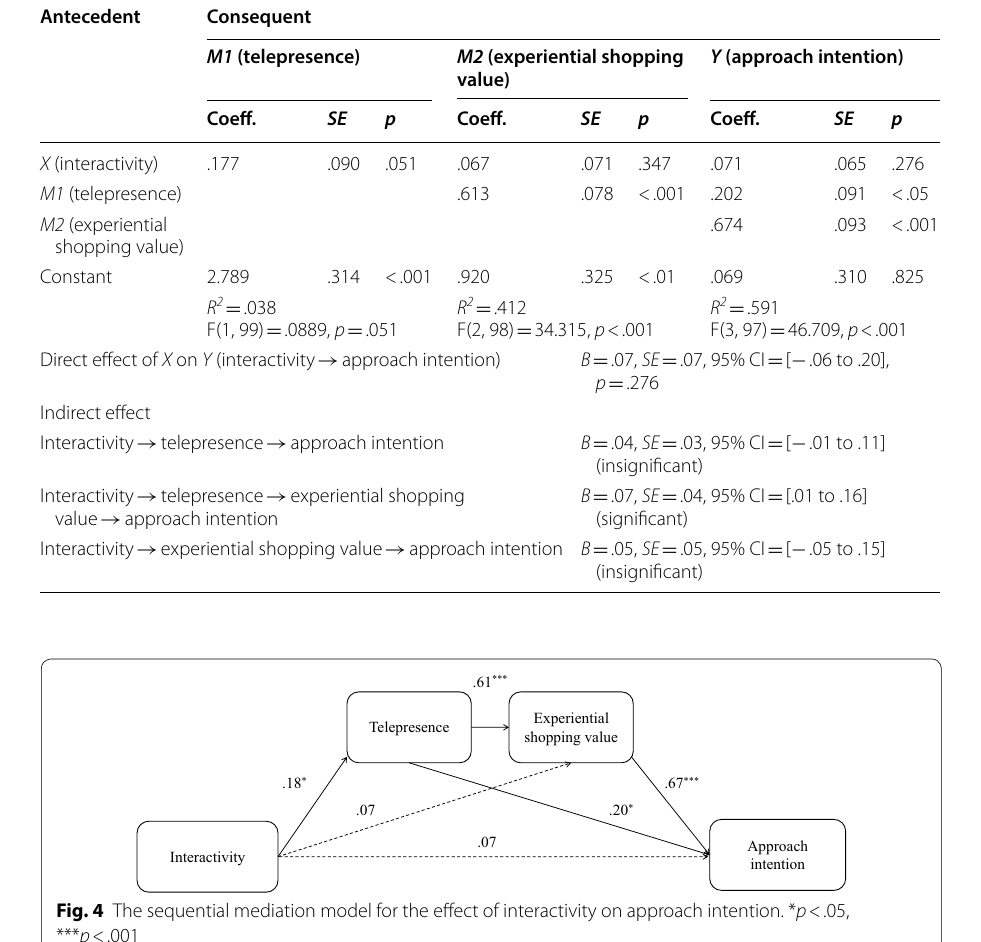
Table 4 Model coefficients of the sequential mediation model: the effect of interactivity on approach intention